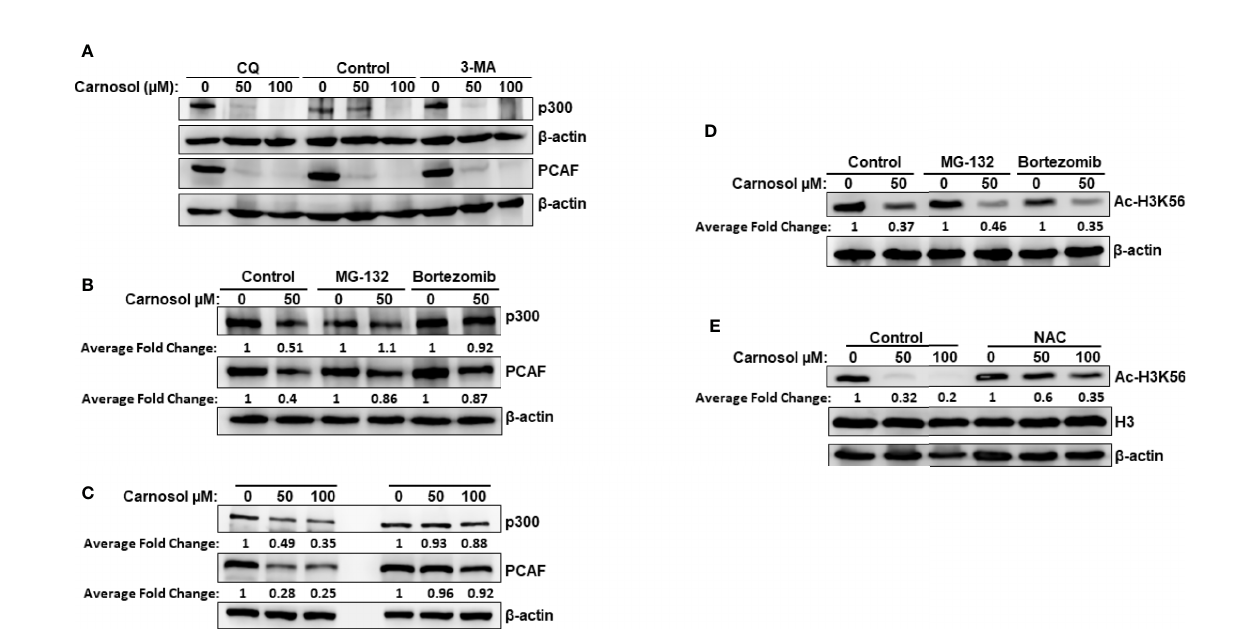
FIGURE 3 | Carnosol promotes a ROS-dependent proteasome degradation of p300 and PCAF in MDA-MB-231 cells. (A) Western blot analysis of p300 and PCAF protein level in MDA-MB-231 cells pre-treated with the autophagy inhibitors 3-MA and CQ. Cells were pretreated with or without 3-MA (50 mM) and CQ (50 m M) for 1 h and before addition of carnosol and incubation for another 24 h. (B) Carnosol induces proteasome-dependent degradation of p300 and PCAF. MDA-MB-231 were pre-treated for 1 h with or without the proteasome inhibitors MG-132 (15 m M) or Bortezomib (25 nM) before treatment with carnosol. (C) ROS-dependent proteasome degradation of p300 and PCAF. MDA-MB-231 were pre-treated for 1 h with the ROS scavenger, NAC, before adding carnosol (50 and 100 m M). Whole cells lysates were resolved on 6% SDS-PAGE and analyzed by Western blot for p300 and PCAF proteins. (D, E) Rescue of p300 and PCAF, by proteasome inhibitors (D) and ROS scavenger (E) did not restore the acetylation of H3K56, a preferred p300 substrate. In all Western blot experiment, 30 m g of whole cell extracts was loaded in each lane. The intensities of the bands were quanti fi ed using the ImageJ software (National Institute of Health, USA). Data shown are representative of three independent